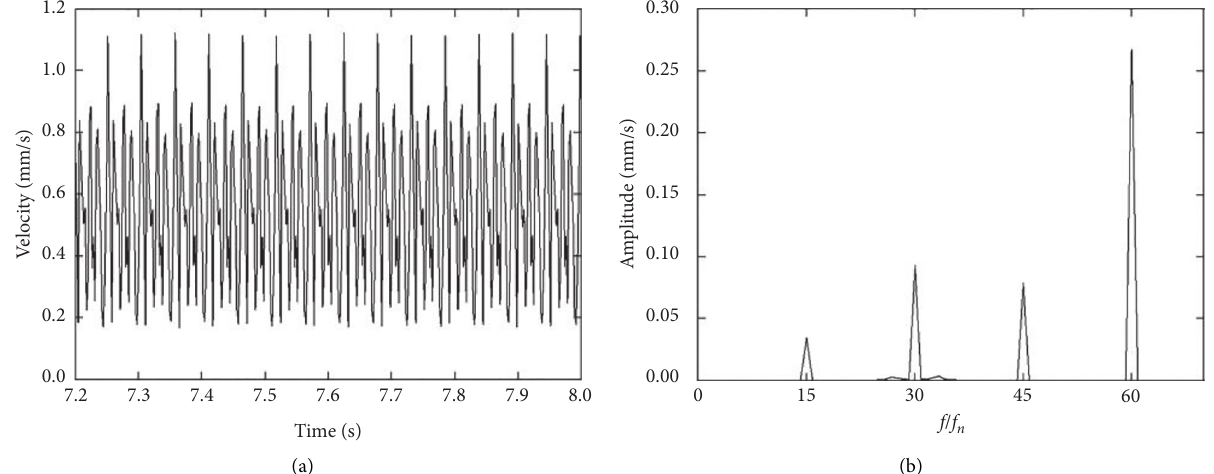
Figure 14: Velocity fluctuation analysis of the extreme velocity point ( B ). (a) Time-domain graph. (b) Frequency-domain graph.